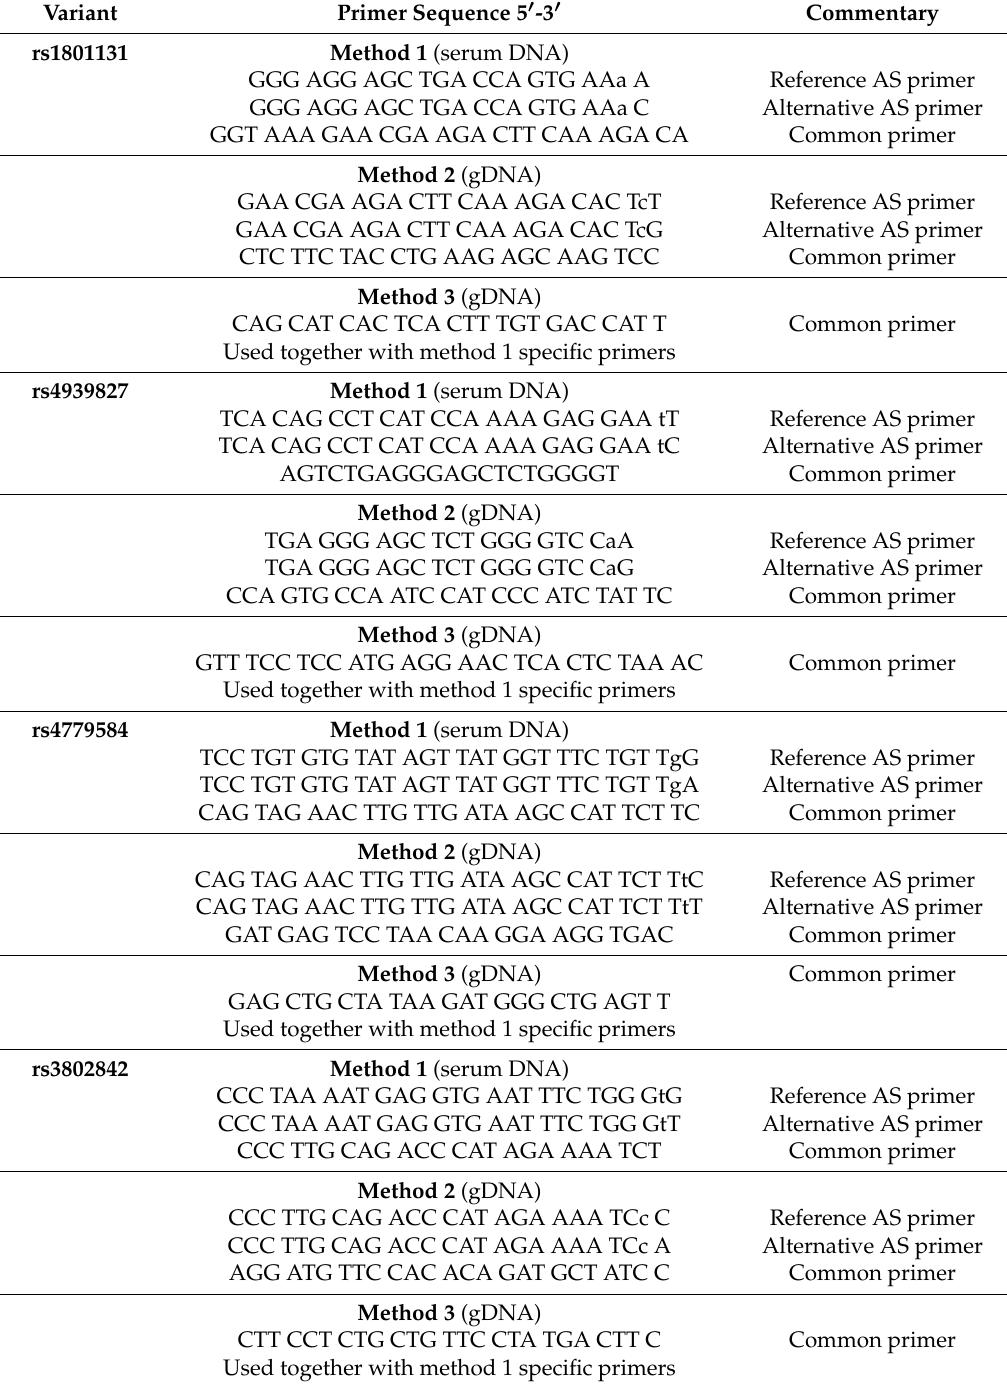
Table 2. Allele-specific primers sets used for SNP